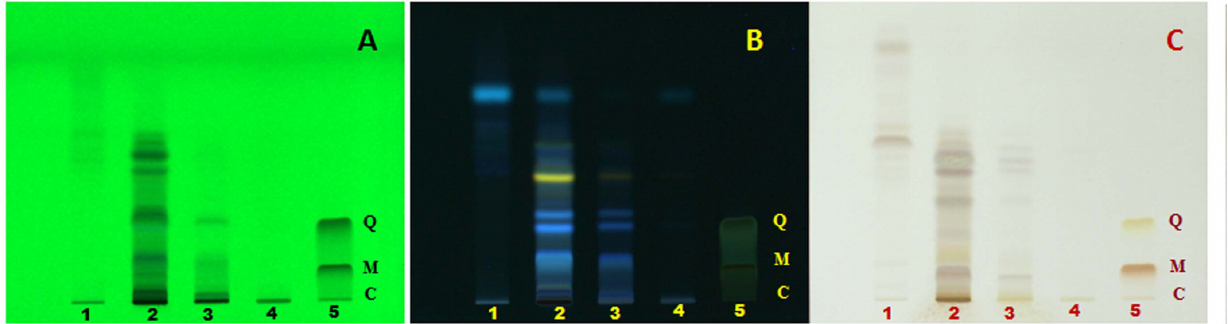
Figure 10. HPTLC fingerprint of extracts of bulbs of D.bulbifera. (1) Petroleum ether extract, (2) Ethyl acetate extract, (3) Methanol extract, (4) Ethanol extract (70% v/v) at (A) 254 nm, (B) 366 nm and (C) 600 nm. Standards used are quercetin (Q), myricetin (M) and catechin (C) in lane 5.